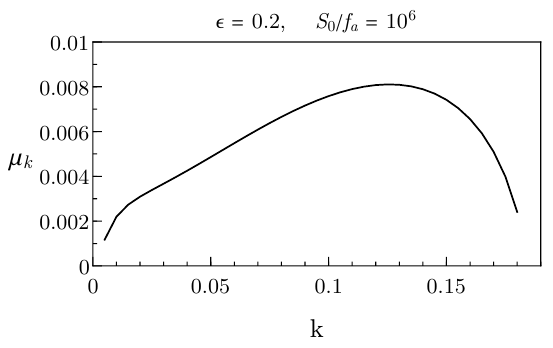
Figure 10 . The growth rate the axion fluctuations for (cid:15) = 0 . 2 and S 0 /f a = 10 6